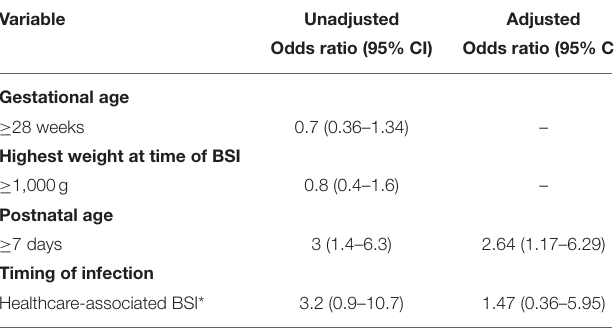
TABLE 5 | Predictors of antimicrobial prescription errors in very low birth weight neonates.